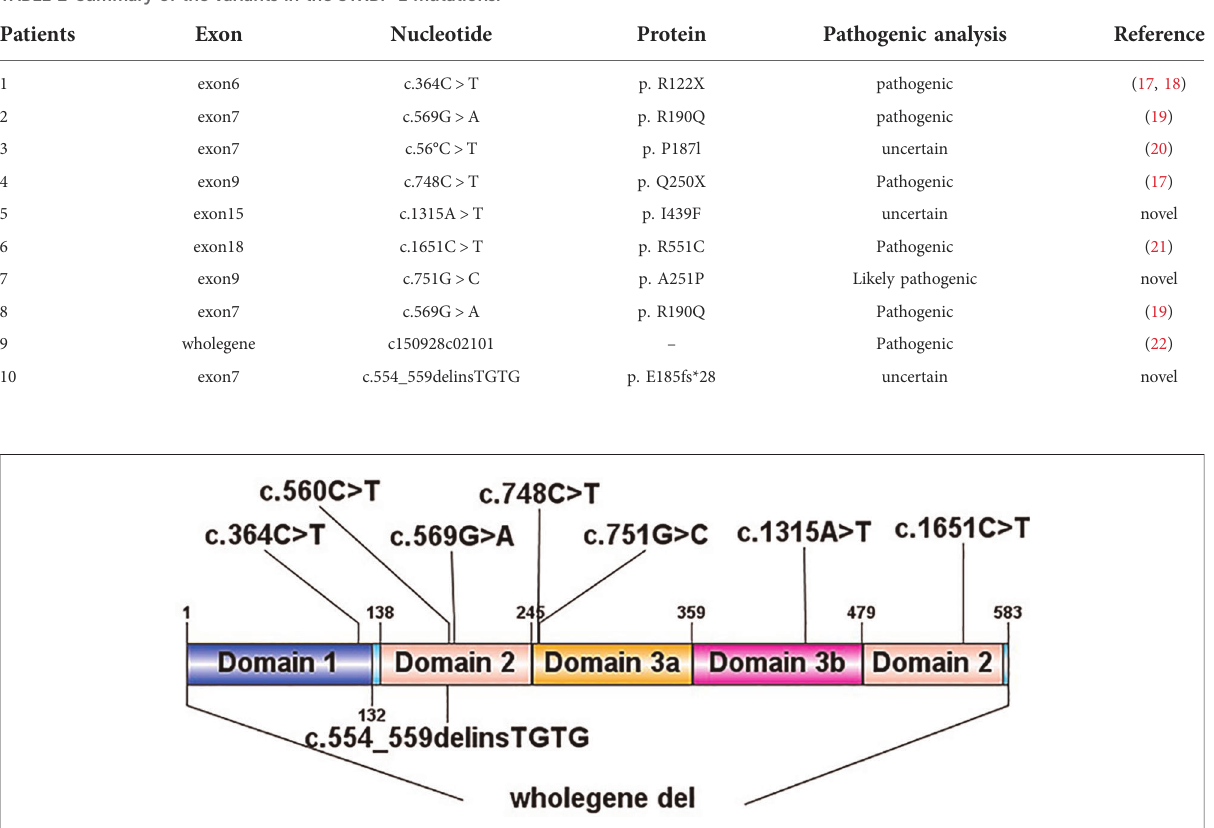
TABLE 2 Summary of the variants in the STXBP-1 mutations.